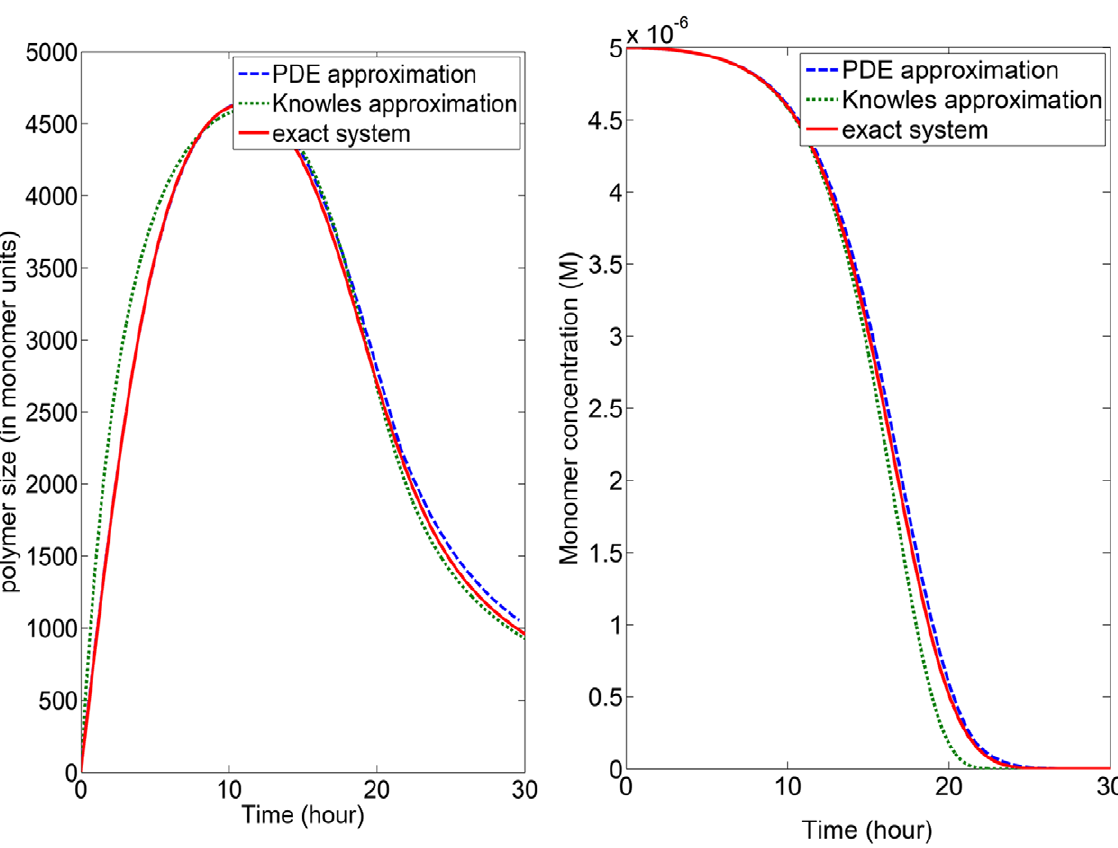
Figure 3. Numerical solution of Equation (21) (22) either using the exact equations, directly representing (potential) experimental data, the PDE approximation, or the analytical approximation proposed in [ 7 ] . Left: average size of polymers. Right: monomers concentration. It is clear that the PDE approximation gives excellent results. The parameters used for the exact equations (i.e. values for elongation rate, fragmentation rate and nucleus size) are those from Fig. 1 of [7].